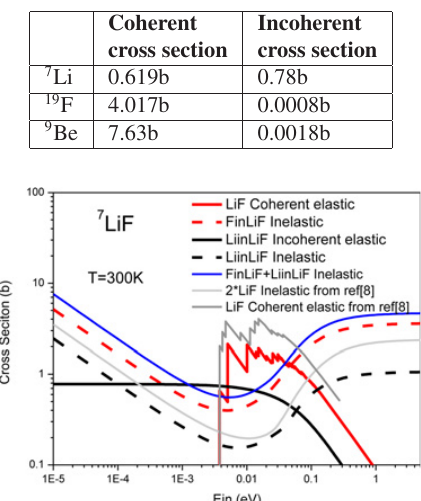
Table 1. Bound atom cross section.